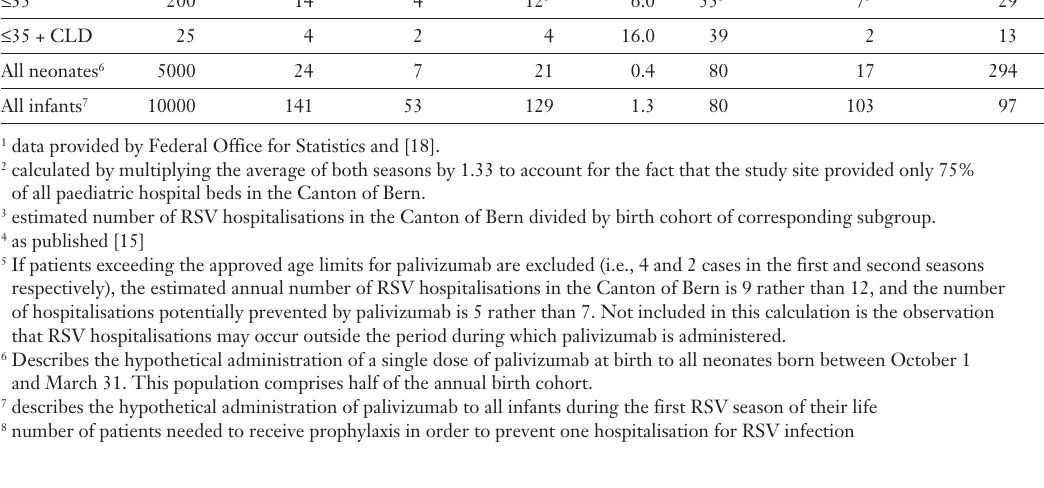
Estimated RSV hospitalisation rates and effectiveness of palivizumab in infants under 12 months of age in the Canton of